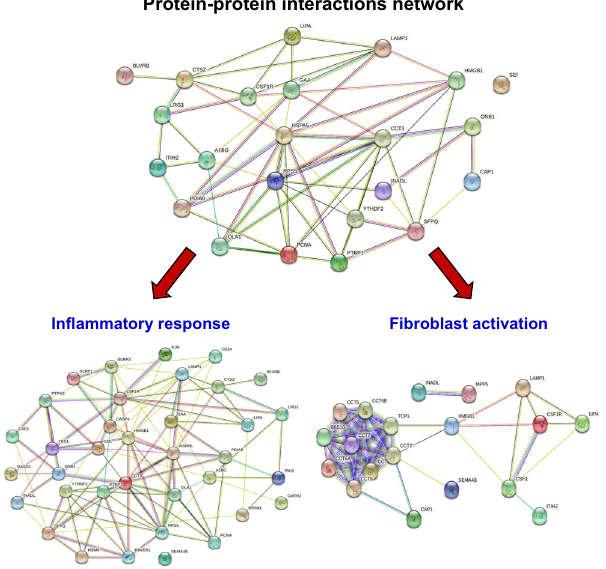
Fig. 4 Protein – protein interactions network analysis. Protein – protein interactions network of all signi fi cantly altered secreted proteins from secretome of the COM-exposed vs. control macrophages were analyzed by STRING tool (version 11.0) (www.string-db.org). The data indicated that the signi fi cantly altered secreted proteins were involved mainly in “ in fl ammatory response ” and “ fi broblast activation ” .